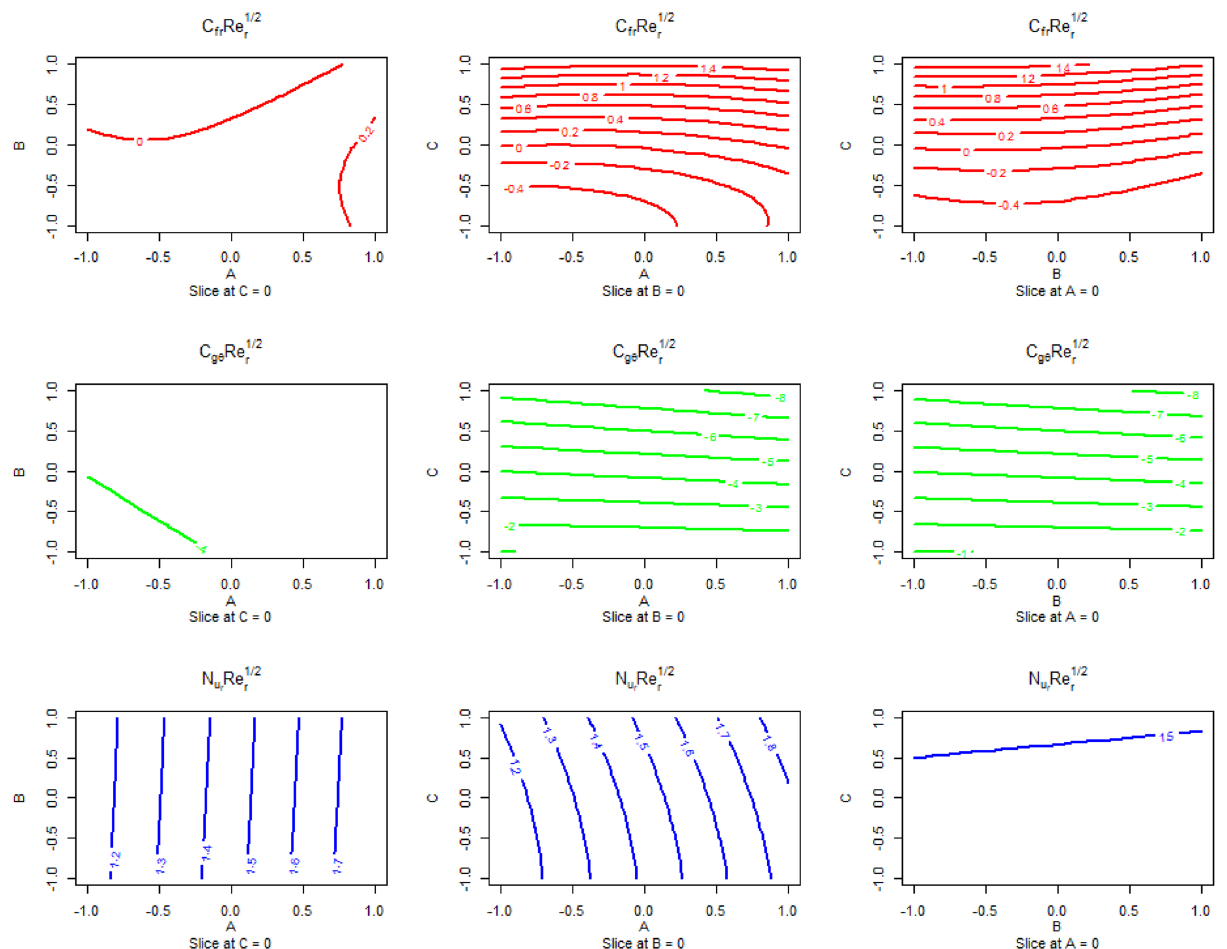
Figure 11. Predicted responses as a function of input parameters coded level with Nanoparticle volume fraction and Magnetic parameter, Magnetic parameter, and suction parameter and Nanoparticle volume fraction and suction parameter are presented for skin friction coefficients C fr Re 1 / 2 Re coefficient C g θ r in the middle panel and for the local Nusselt number Nu r Re − ∗